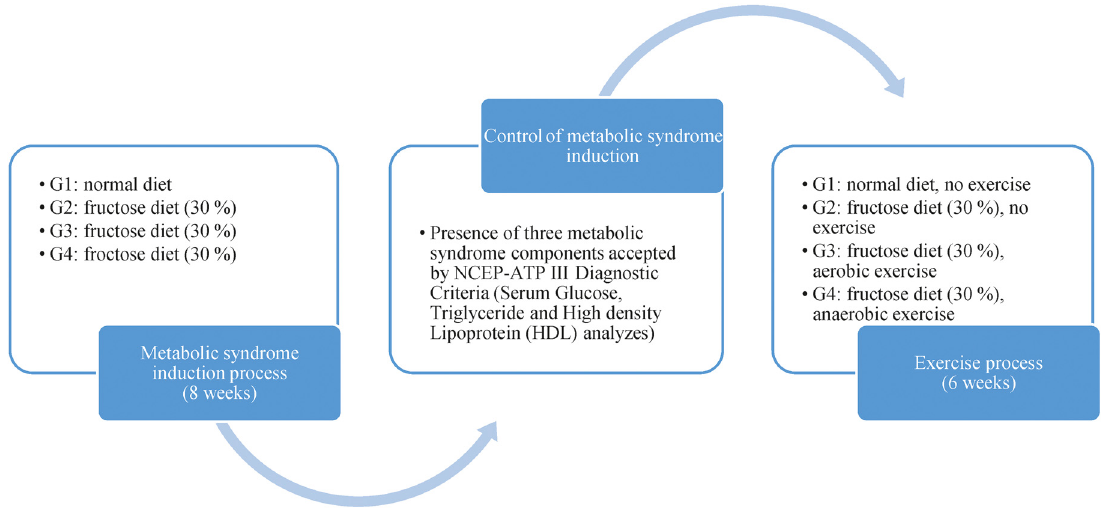
Figure 1: The process of